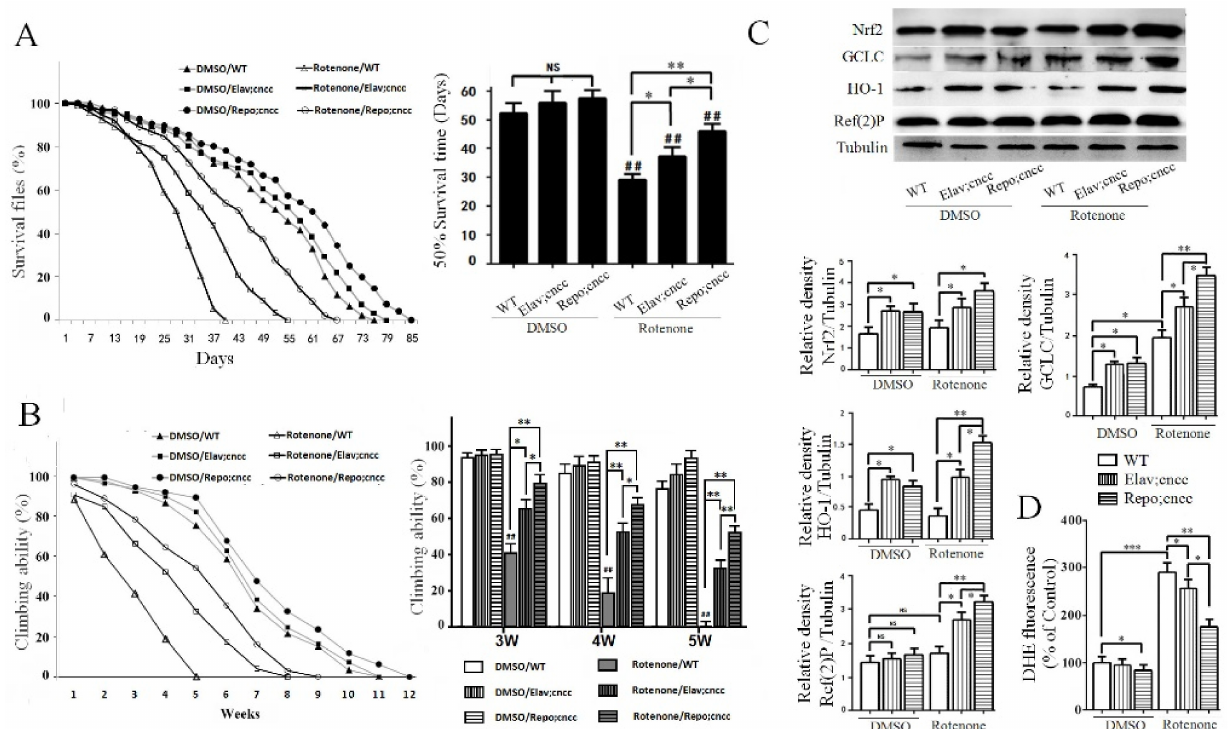
Figure 4. Overexpression of Nrf2 in glial cells suppressed rotenone-induced PD-like phenotypes in flies. ( A ) survival curve and statistical analysis by Log-rank test and half survival time. Nrf2 overexpression in DMSO control drosophila did not significantly improve survival time in the DMSO/Elav;cncc or DMSO/Repo;cncc group compared with the DMSO/WT control group (NS p > 0.05). Rotenone treatment significantly shortened survival time compared with the corresponding DMSO control group ( ## p < 0.01). Nrf2 overexpression in neurons of PD model Drosophila significantly increased survival time in the rotenone/Elav;cncc group compared with the rotenone/WT group (* p < 0.05). Nrf2 overexpression in glial cells more significantly increased survival time in the rotenone/Repo;cncc group compared with the rotenone/Elav;cncc group and the rotenone/WT group (* p < 0.05 and ** p < 0.01). ( B ) The left graph shows climbing ability throughout lifetime. The right bar graph shows the climbing ability at ages of 3–5 weeks. Rotenone treatment significantly reduced climbing ability in the rotenone/WT group compared with the DMSO group ( ## p < 0.01). Nrf2 overexpression in glial cells in the rotenone/Repo;cncc group more significantly improved the motor ability than overexpression in neurons in the rotenone/Elav;cncc group (* p < 0.05 and ** p < 0.01). ( C ) Western blot analysis of Nrf2, GCLC, HO-1, and Ref(2)P proteins in Drosophila brain homogenates. The bar graph below is the quantitative analysis of Western blot bands. Nrf2 overexpression in neurons and glial cells increased GCLC and HO-1 in the Elav;cncc and Repo;cncc group compared with the WT control group (* p < 0.05 and ** p < 0.01). Nrf2 overexpression in glial cells further increased Nrf2, GCLC and HO-1 in the Repo;cncc group compared to overexpression in neurons in the Elav;cncc group (* p < 0.05). The Nrf2 overexpression significantly increased Ref(2)P in the rotenone/Elav;cncc and rotenone/Repo;cncc groups compared with the